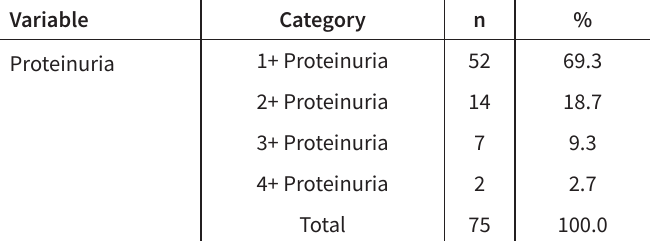
Table 3. Distribution of Patients with Varying Grades of Proteinuria Variable